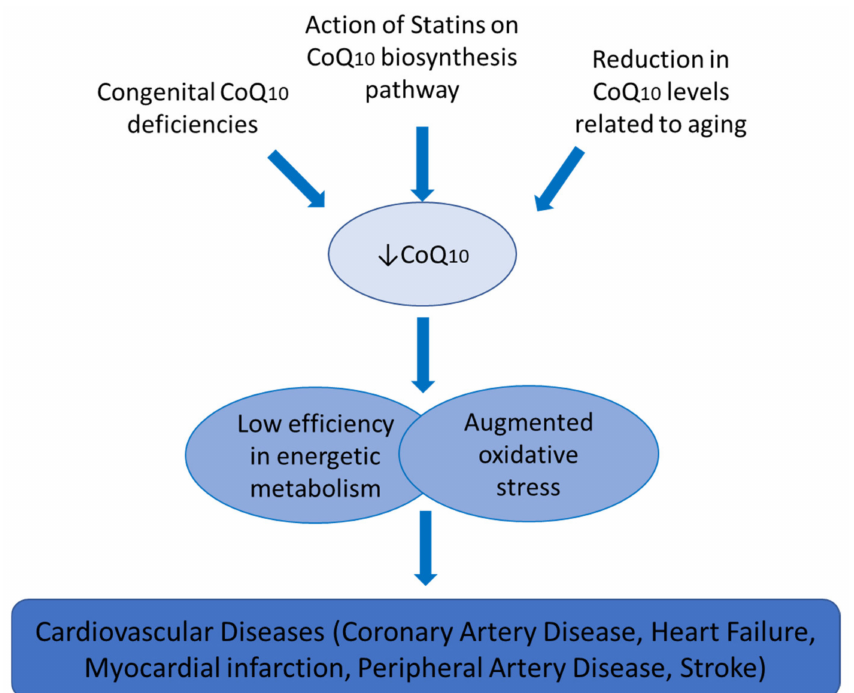
Figure 2. Coenzyme Q 10 and cardiovascular